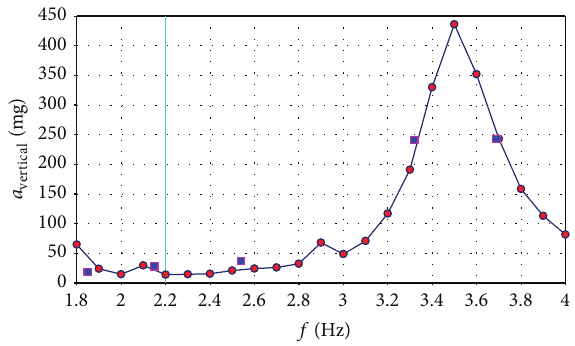
Figure 12: Comparison of amplitudes at mid-span (vertical accel- eration) between in situ measurements and the analytical model: 1 person walking at various speeds (steel box-girder structure). Red circles: analyticalmodel; bluesquares; in situ measurements; vertical line at 2.2 Hz separates “walk” from